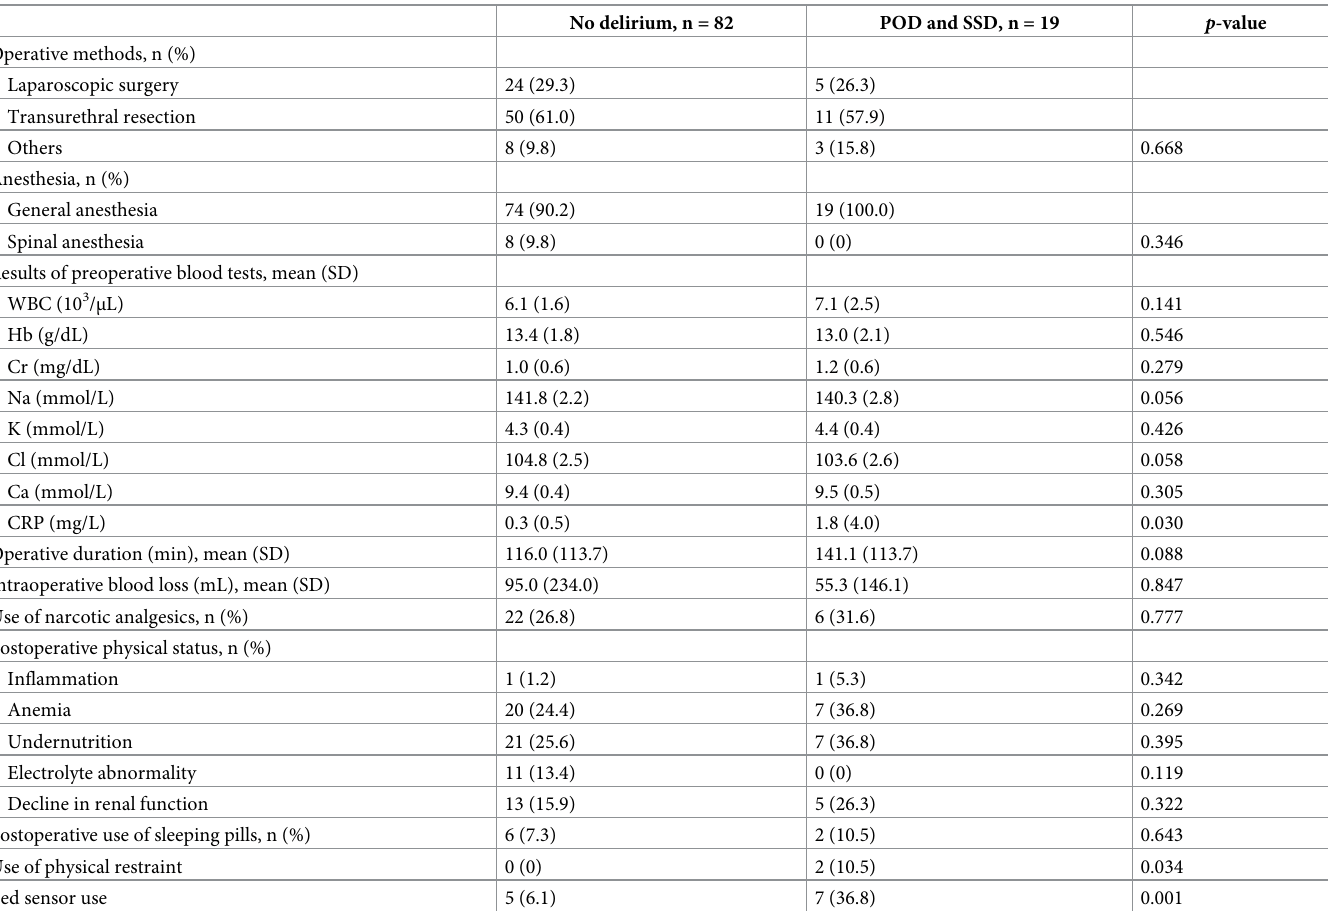
Table 4. Differences in surgical clinical variables (no delirium vs. POD and